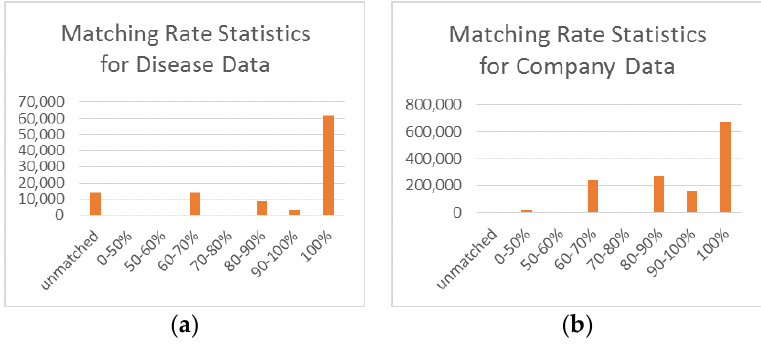
Figure 15. Matching rate statistics: ( a ) for the disease data; and ( b ) for the company data.